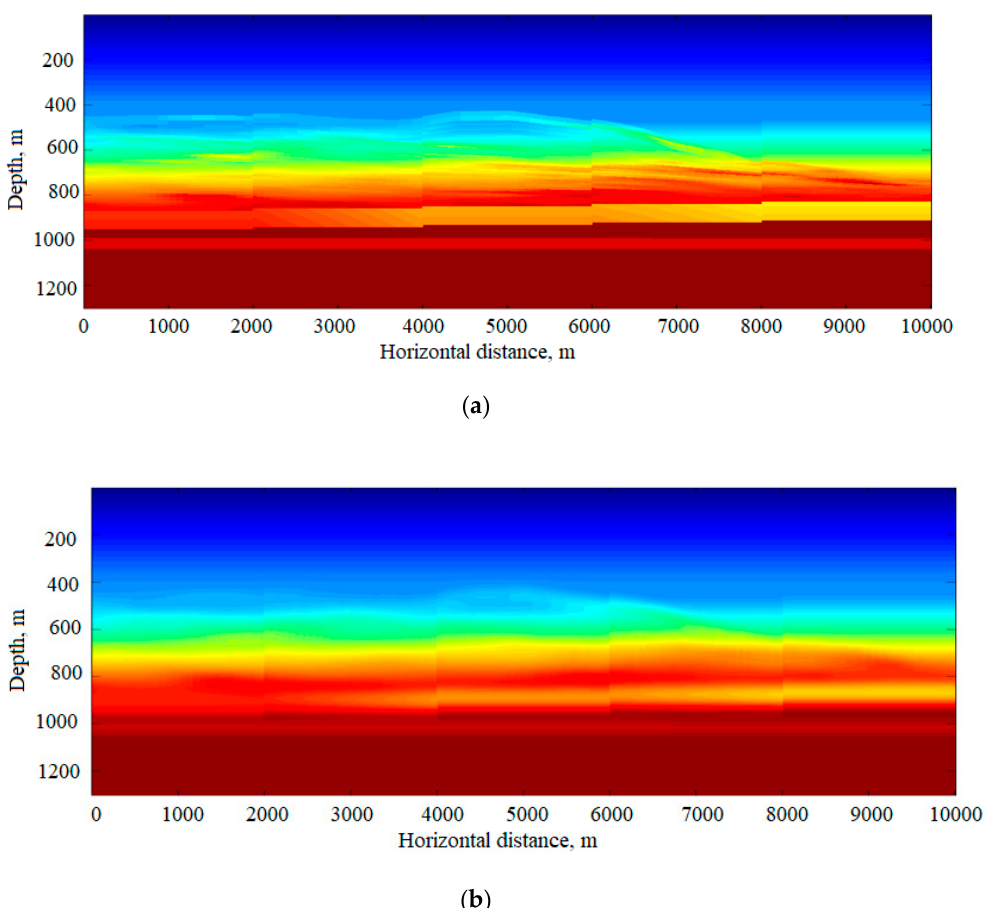
Figure 6. The vertical cross-section of the paleo-channel model. ( a ) No smoothing ( b ) After smoothing.